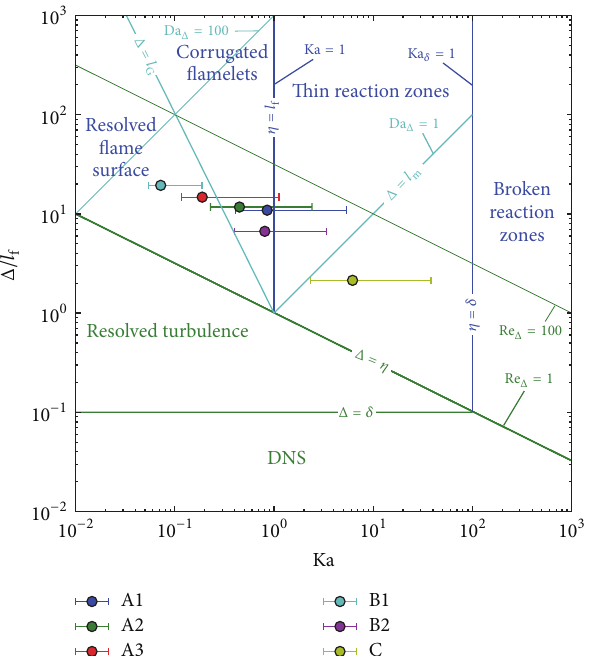
Figure 10: Location of all cases on a regime diagram for LES and DNS of premixed turbulent combustion proposed by